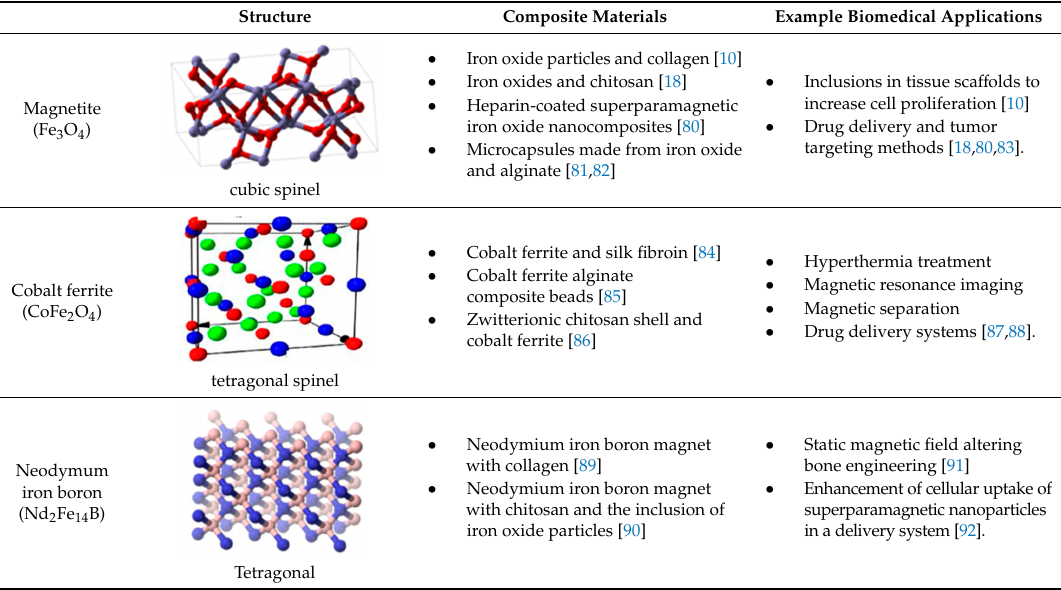
Table 1. Common medical applications of magnetic particles used today.